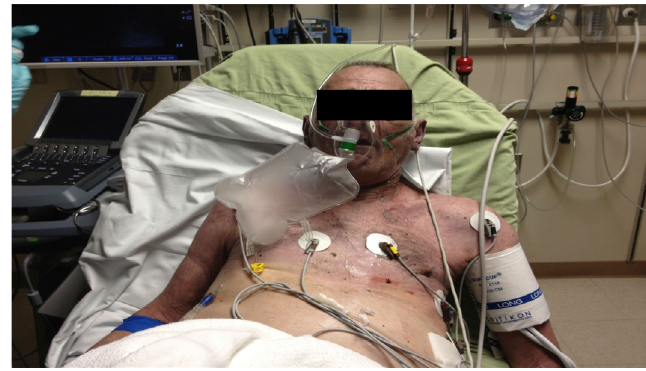
Figure 1. Patient demonstrating sharp line of demarcation inferior to nipples separating pallor (inferior) and plethora